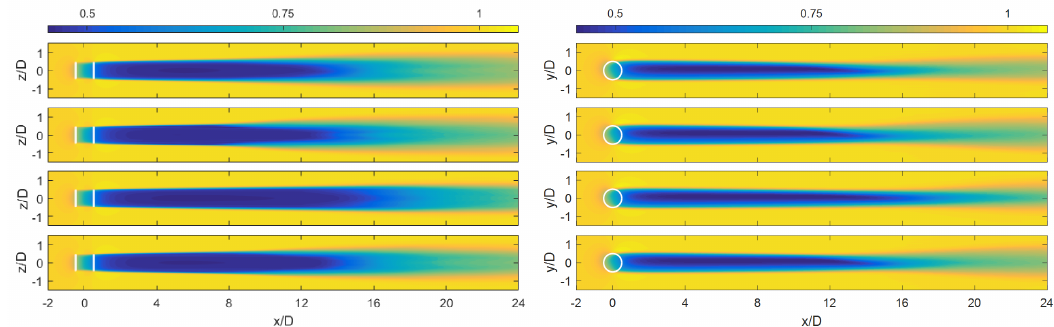
Figure 3. Contours of the normalized mean streamwise velocity ( U / U 0 ) in the central vertical x − z plane ( left ) and in the central horizontal x − y plane ( right ) for different SGS models: (from top to the bottom) Lagrangian scale-dependent dynamic (LSDD) model, anisotropic minimum dissipation (AMD) model, standard Smagorinsky model (SMAG) model with C S = 0.16, and SMAG model with C S =